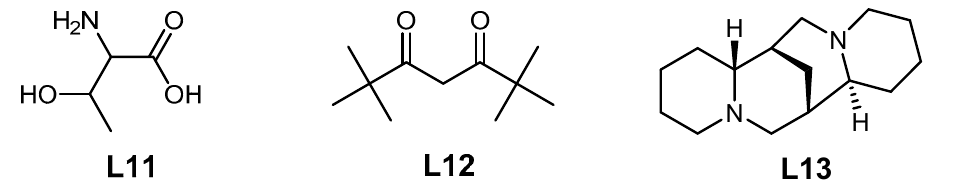
Figure 3. Ligands are applicable for coupling phenols with different Ar-Xs.